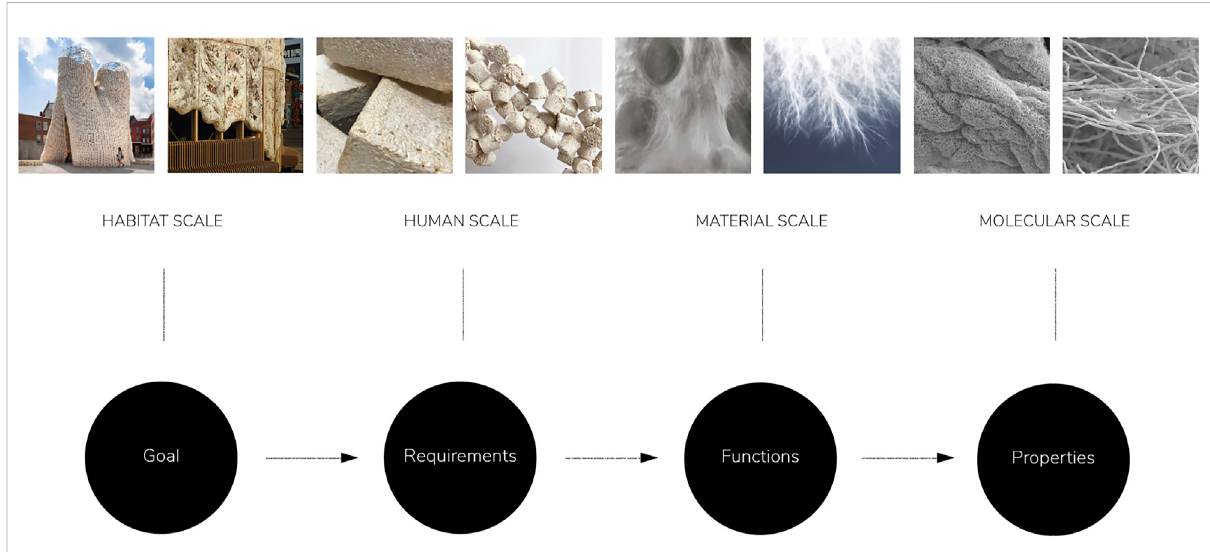
FIGURE 10 Example of properties and functions of mycelium biocomposite — radiation